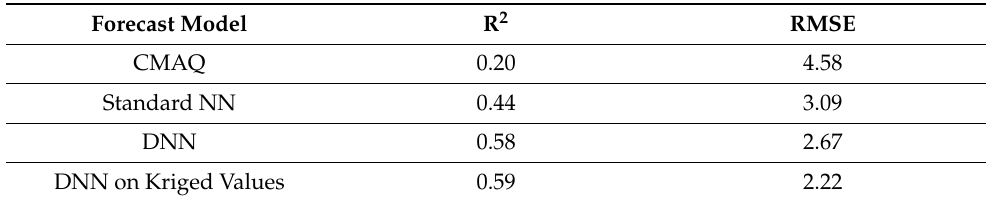
Table 3. Table of forecasting scores for all models